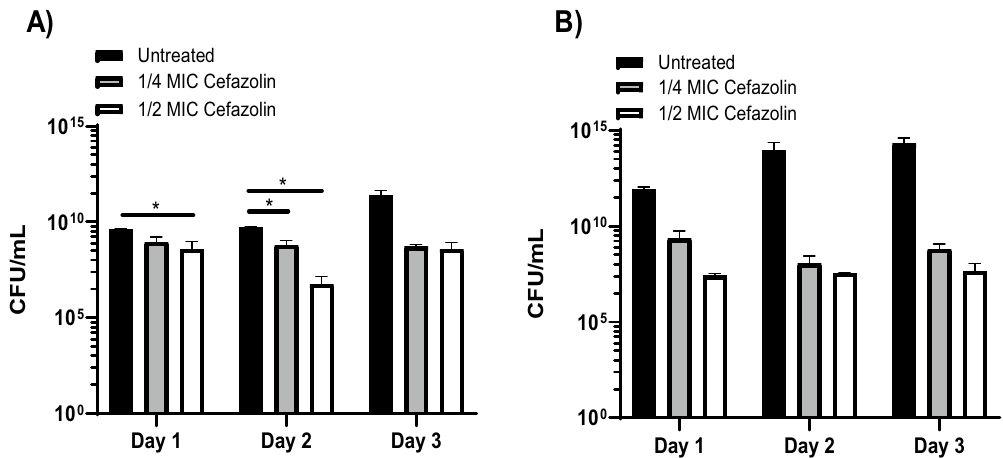
Figure 2. Sub-MIC cefazolin does not promote S. aureus planktonic growth. Sub-MIC cefazolin results in decreased planktonic growth in ( A ) MSSA Newman and ( B ) SH1000. *p < 0.05.